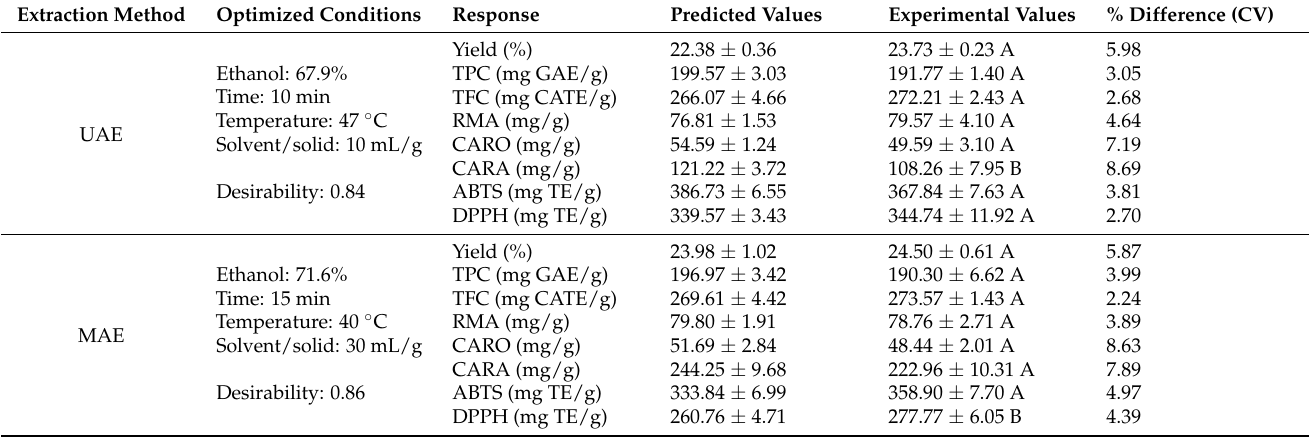
Table 5. Optimal conditions obtained by the response surface methodology for microwave-assisted extraction (MAE) and ultrasound-assisted extraction (UAE) as well as the experimental and predicted values of the investigated